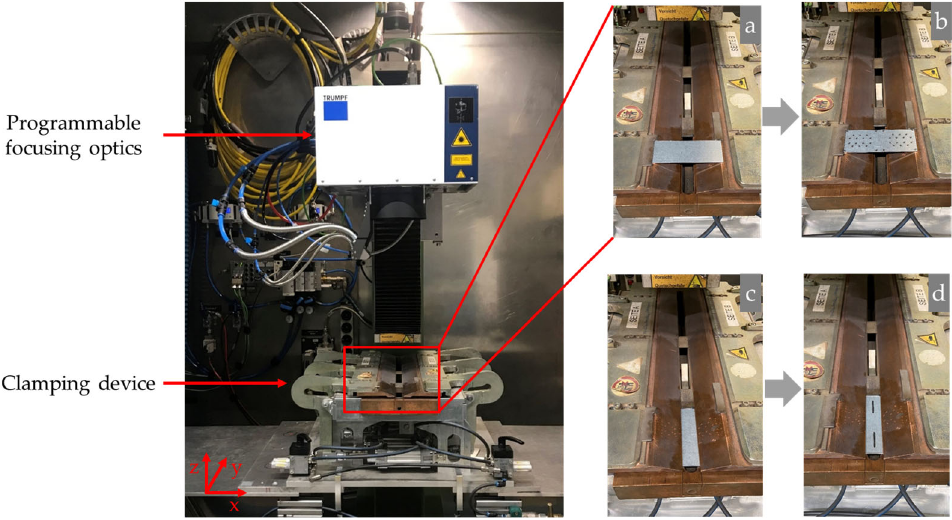
Figure 5. Welding and clamping set ‐ up and dimpling and welding